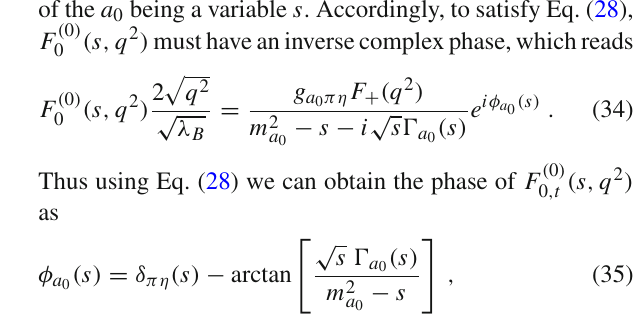
Fig. 1. After inserting Eqs. (31) and (34) into Eq. (25),